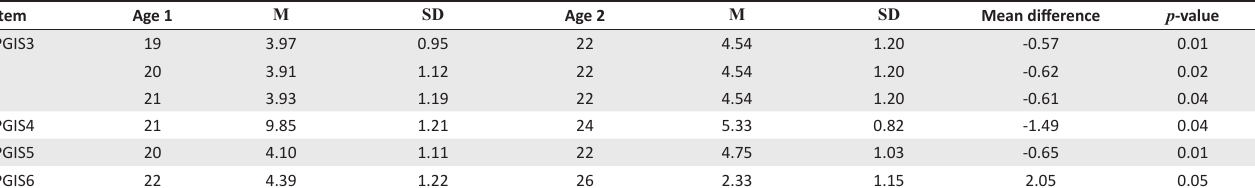
TABLE 4: Significant mean differences between age groups in terms of PGI for the I-O Psychology students ( N = 565). Item Age 1